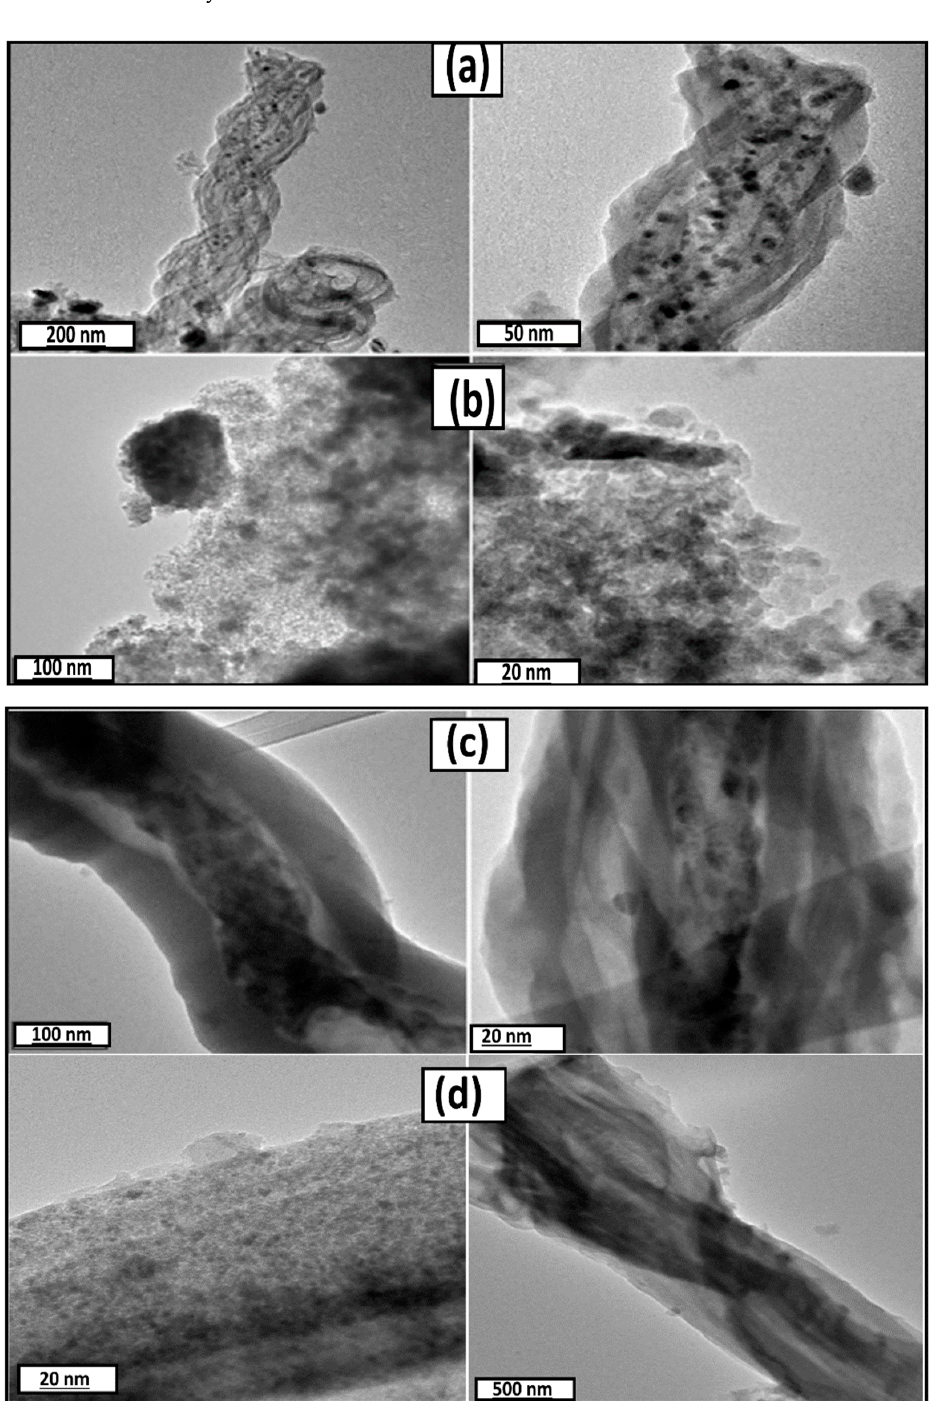
Figure 4. Transmission electron micrographs of the calcined ( a ) Co/NS, ( b ) Co/Al 2 O 3 , ( c ) Co/NS-Al-A and ( d ) Co/NS-Al-B catalysts.